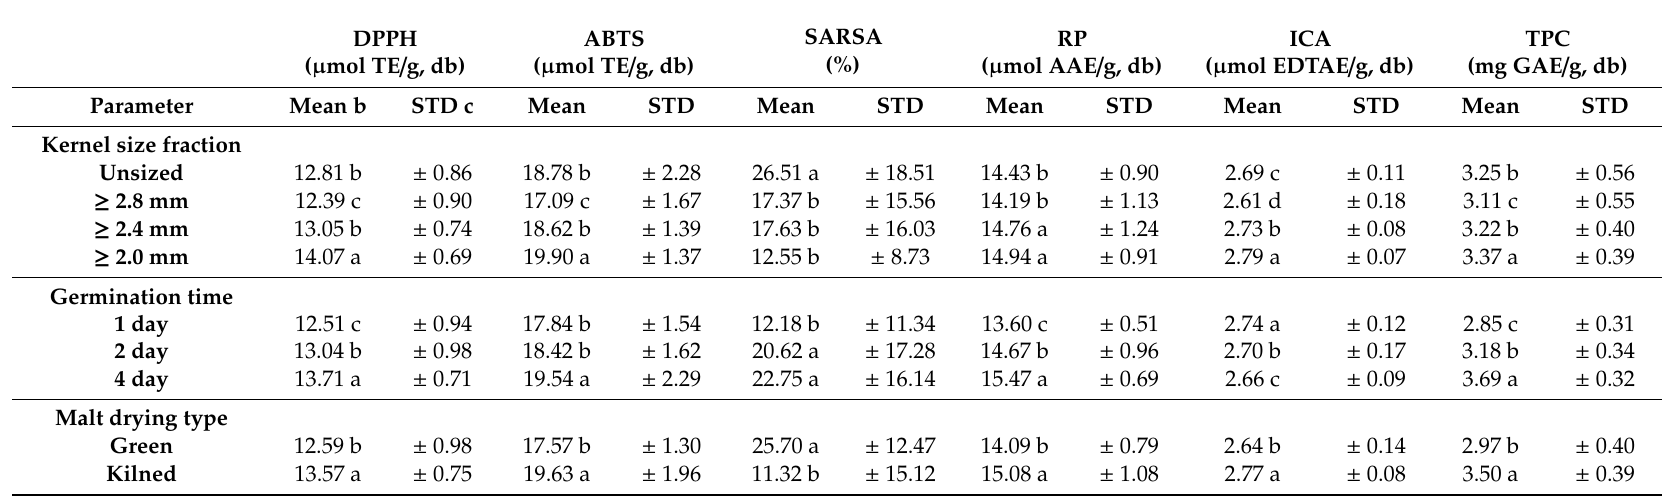
Table 3. Mean and Range of Antioxidant Activities and Total Phenolic Content in Malt as A ff ected by Kernel Size Fractions, Germination Time, and Malt Drying a